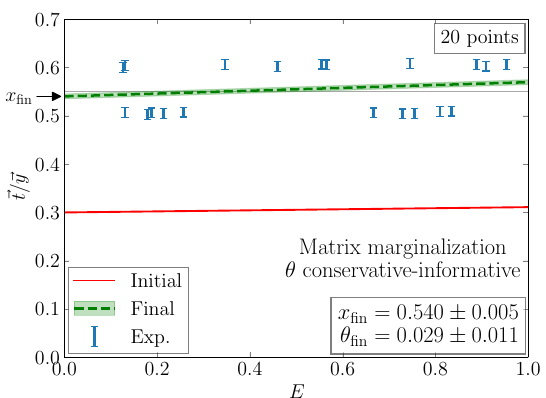
Figure 4. Uncertainty propagation with the conservative- informative “matrix marginalization” technique using a reduced initial uncertainty on θ : θ ini = 0 . 011 ± 0 . 011.